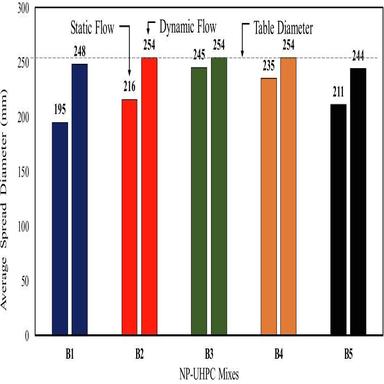
Static and dynamic flow table measurements of the five different fresh NP-UHPC mixes.